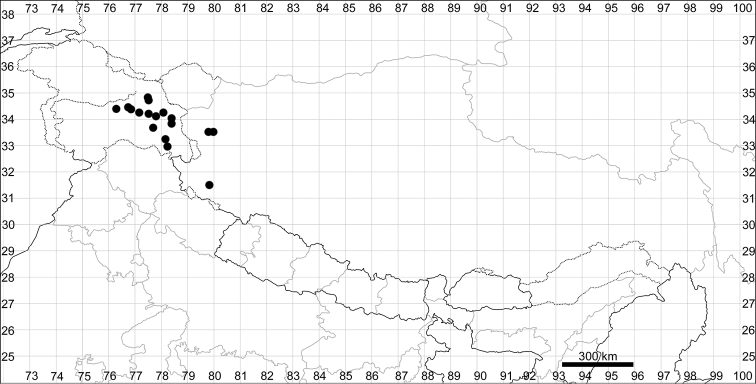
Distribution map of Halogetonglomeratus.